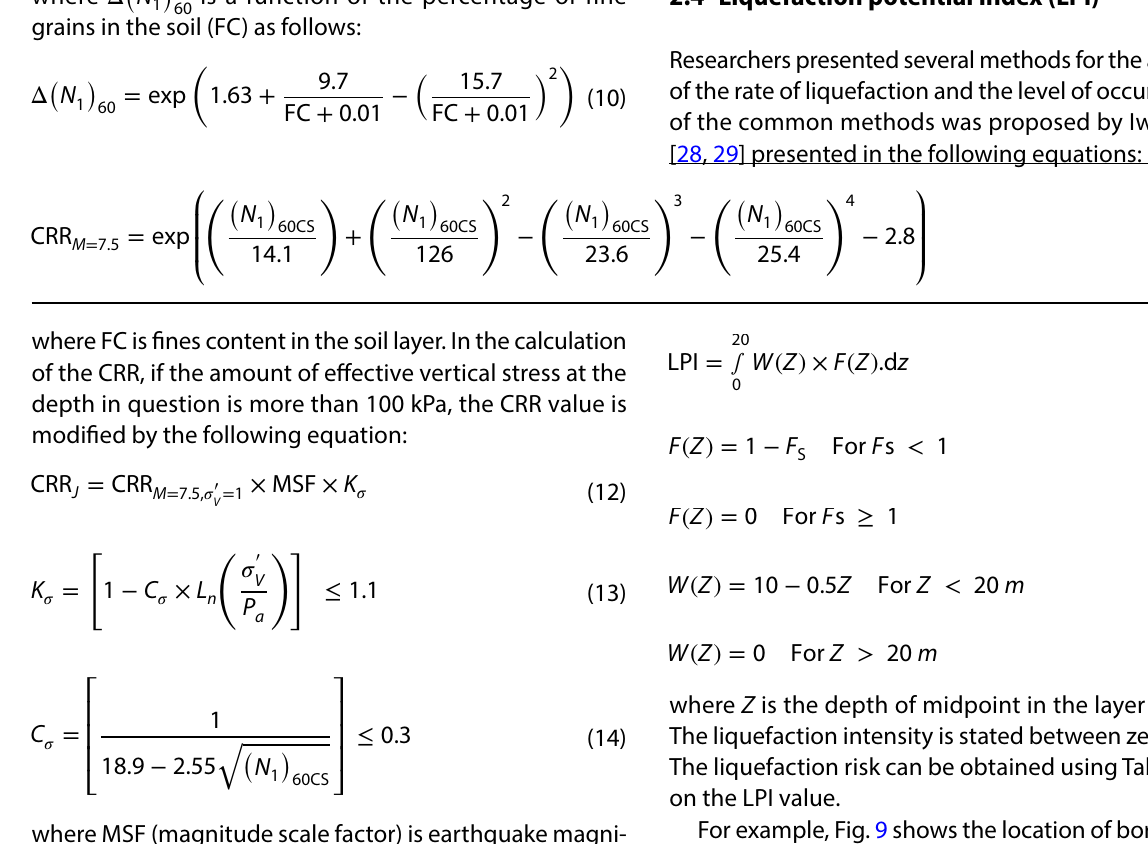
K is the overburden correction factor, σ ΄ σ